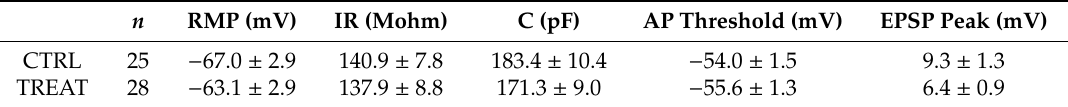
Table 1. Electrophysiological features. Analysis of Cornu Ammonis (CA1) pyramidal neurons in adult o ff spring from creatine-supplemented and unsupplemented